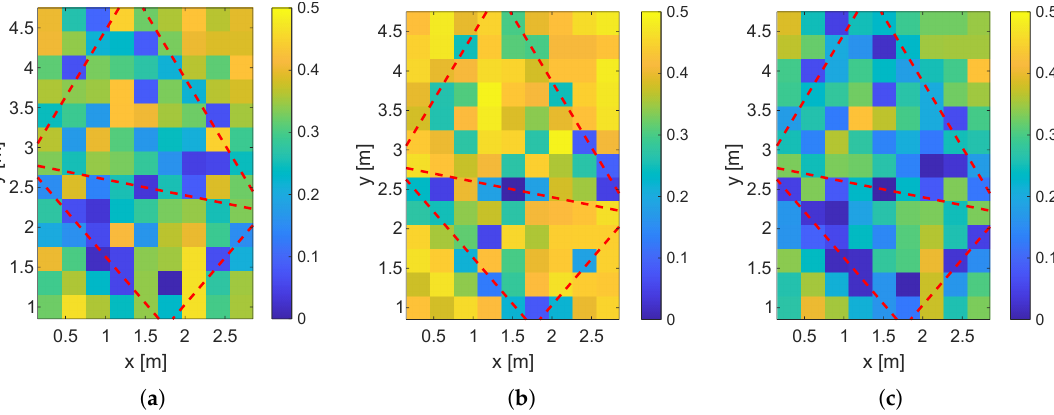
Figure 14. Simulation of p E of the measurement setup. ( a ) Simulated p E for magnitude only. ( b ) Simulated p E for phase differences only. ( c ) Simulated p E for combination of magnitude and phase